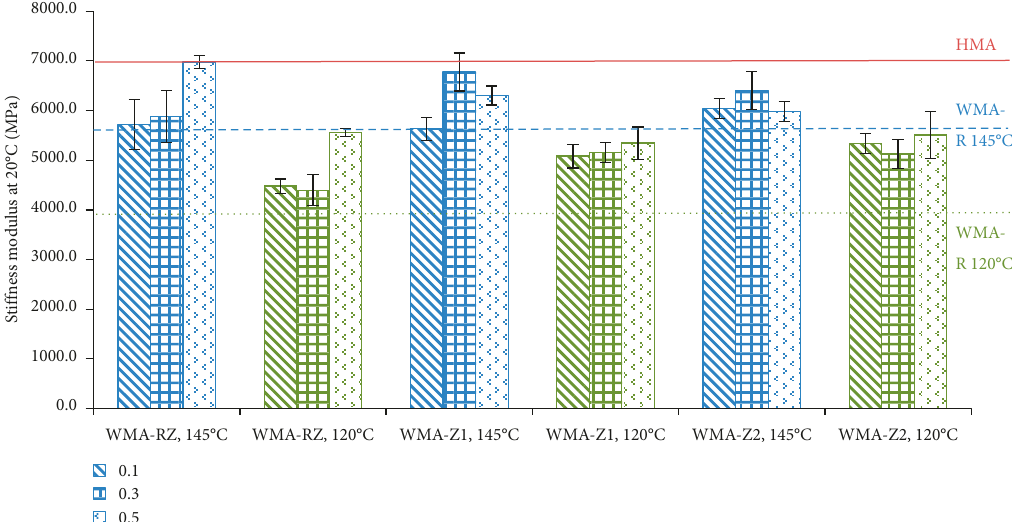
Figure 4: Results of the stiffness modulus from the specimens obtained in the workability